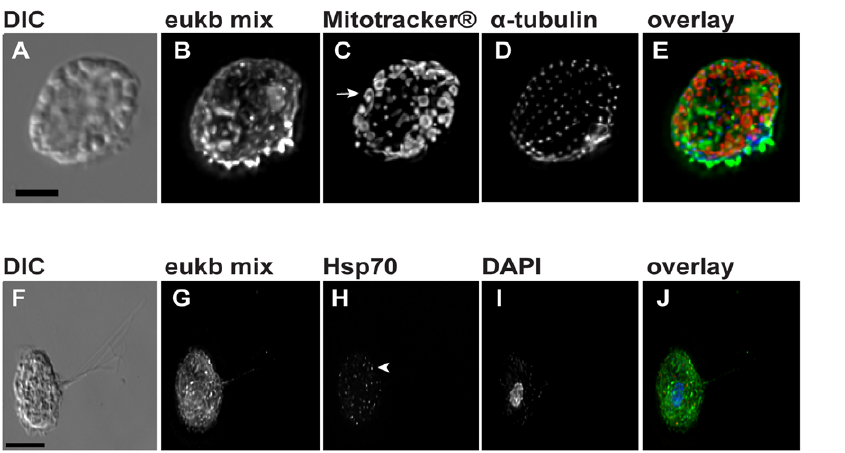
Figure 4. ImmunoFISH in two environments links eukaryotic phylotypes with the subcellular localization of their mitochondria or hydrogenosomes. Live hay infusion (A–E) was incubated with Mitotracker H Red CM-H 2 XRos (C), fixed, hybridized with the eukaryote ssu rRNA probe (B), and overlaid with an anti- a -tubulin antibody to stain cytoskeletal features of each cell (D). Tailed arrow marks ovoid mitochondria. The image overlay (E) shows the eukaryotic ssu rRNA probe (green), Mitotracker H Red CM-H 2 XRos (red), and anti- a -tubulin (blue). Scale bar=10 m m. Fixed termite hindgut samples (F–J) were hybridized with the eukaryote ssu rRNA probe (G), overlaid with and anti-Hsp70 antibody to stain hydrogenosomes (H, arrowhead). The image overlay (J) shows the eukaryotic ssu rRNA probe (green), anti-Hsp70 antibody (red), and DAPI nucleic acid stain (blue). Scale bar=25 m m. Also see 3D stacks of overlays in Video S4.